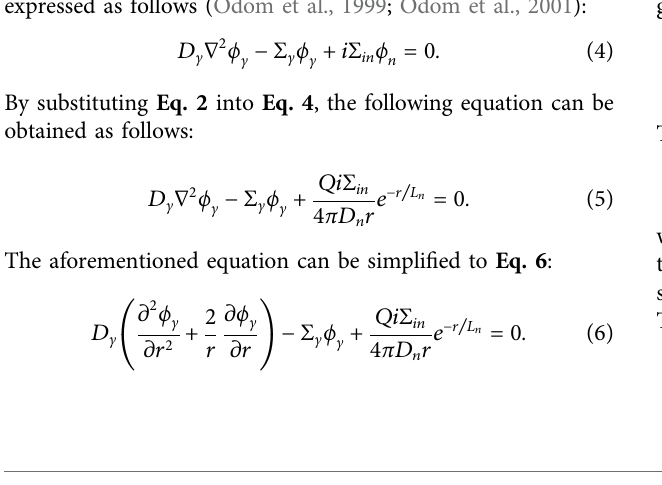
Frontiers in Earth Science |